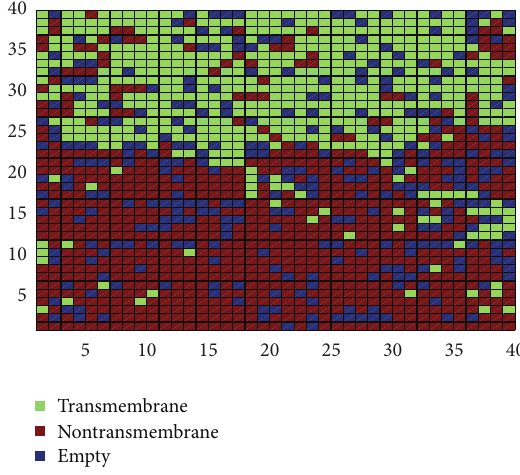
Figure 4: Top map of the optimized network. The transmembrane (green) and nontransmembrane (brown) segments form two differ- ent clusters. Empty neurons are dark